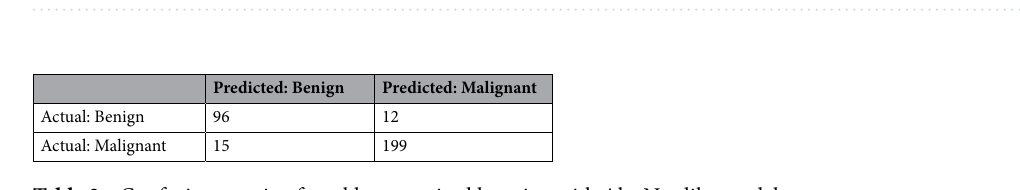
Table 1. Confusion matrix of weakly supervised learning with LeNet-like model.